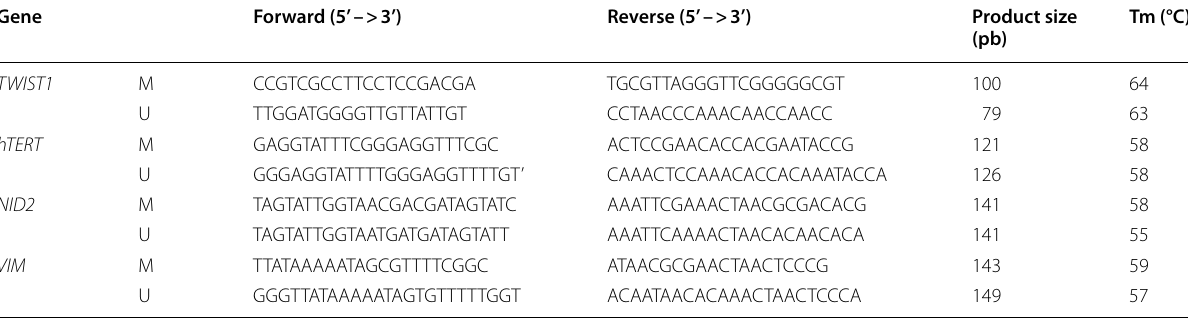
Table 1 Genes primers and corresponding annealing temperatures for MSP Gene Forward (5’ – >